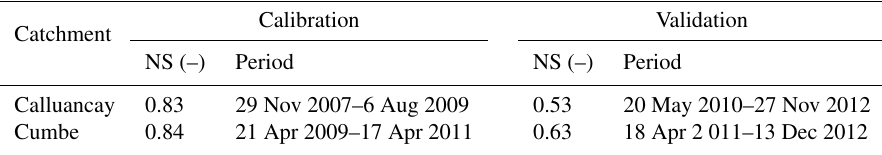
Table 3. The Nash–Sutcliffe efficiencies for the PDM models ∗ .